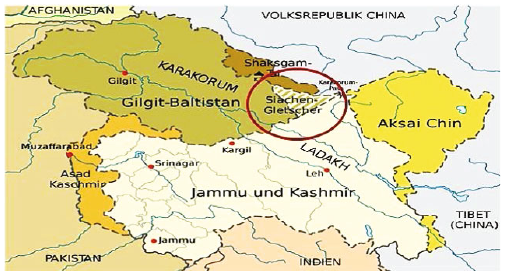
Figure 1: Map location of Siachen Glacier [3].